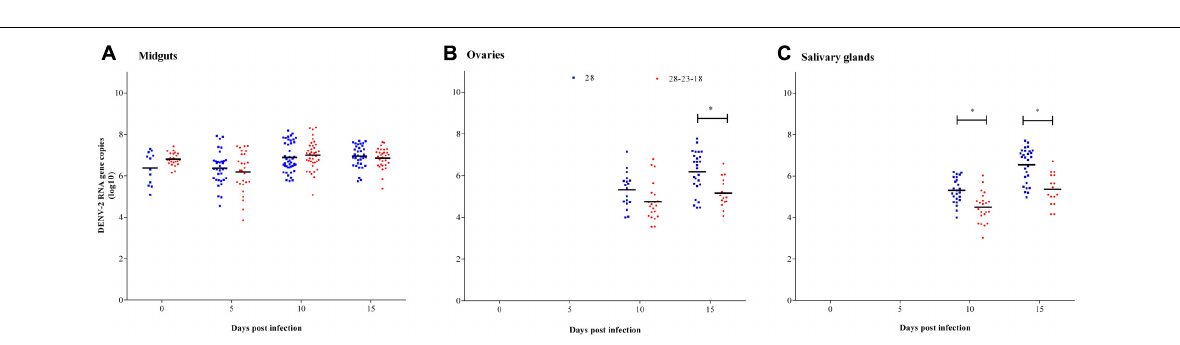
FIGURE 4 | Comparison of DENV-2 RNA copies in tissues of Ae. albopictus between constant and fluctuating temperatures. The amount of DENV-2 in tissues of Ae. albopictus reared at 28 ◦ C and 28–23–18 ◦ C was compared at 0, 5, 10, and 15 dpi. (A) Midguts; (B) ovaries; (C) salivary glands. Horizontal black lines show median DENV-2 copies (log 10 ) at each temperature. ∗ P <